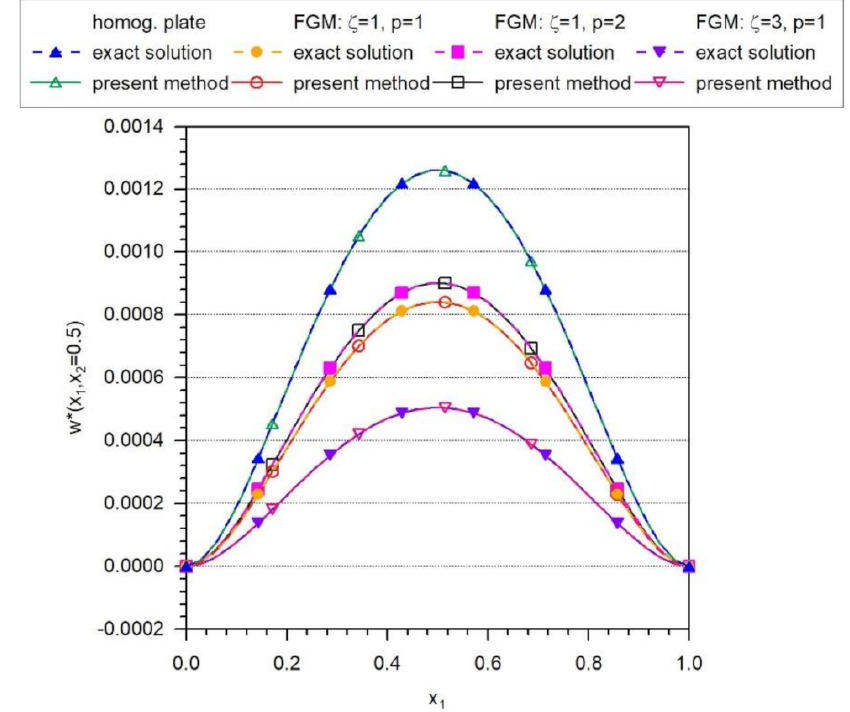
Figure 2. Dimensionless deflections of homogeneous and/or FGM square plates with various parameters of gradation of Young